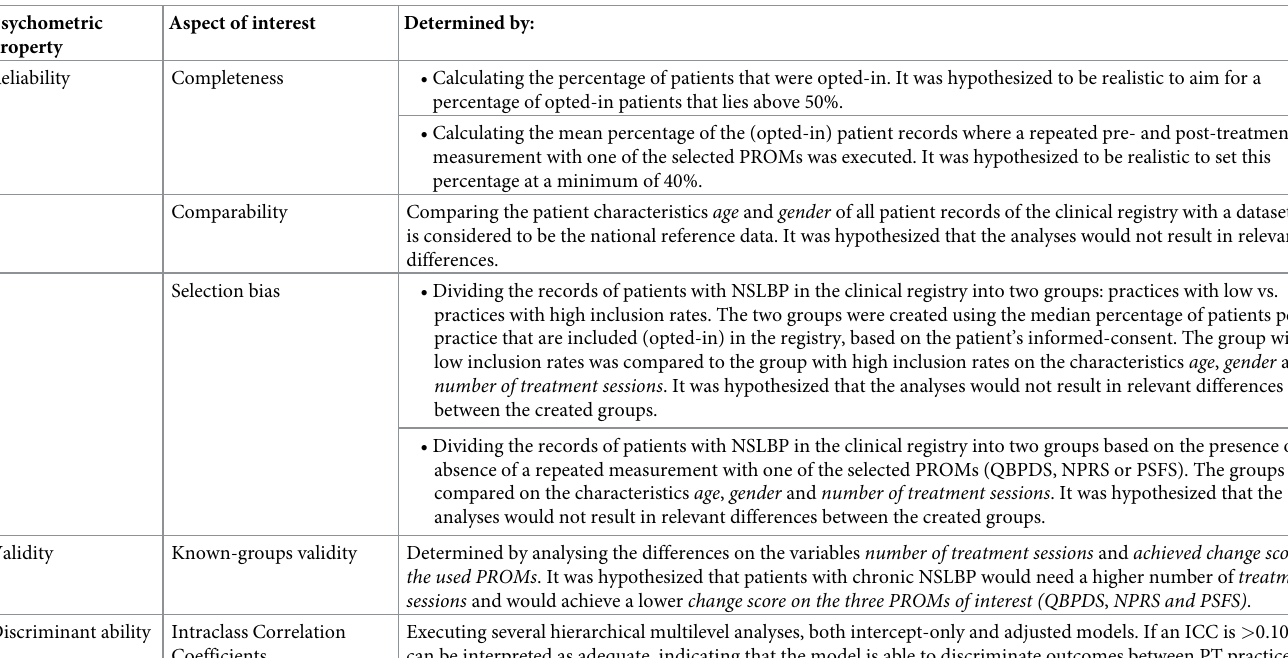
Table 2. A summary on all executed analyses on the different psychometric